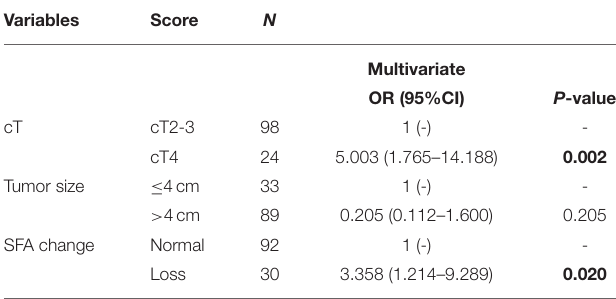
TABLE 3 | Multivariate logistic regression analysis for TRG in LARC patients. Variables